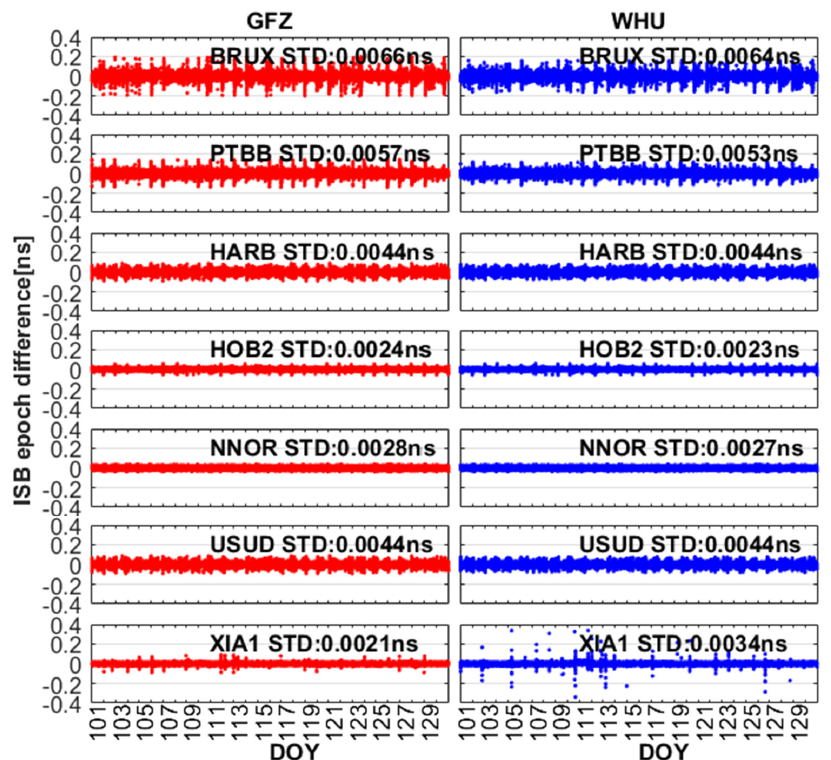
Figure 7. The epoch-differenced ISB between BDS-2 (B1I/B3I) and BDS-3 (B1I/B3I) for GFZ and WHU from DOY 101 to 130, 2020.